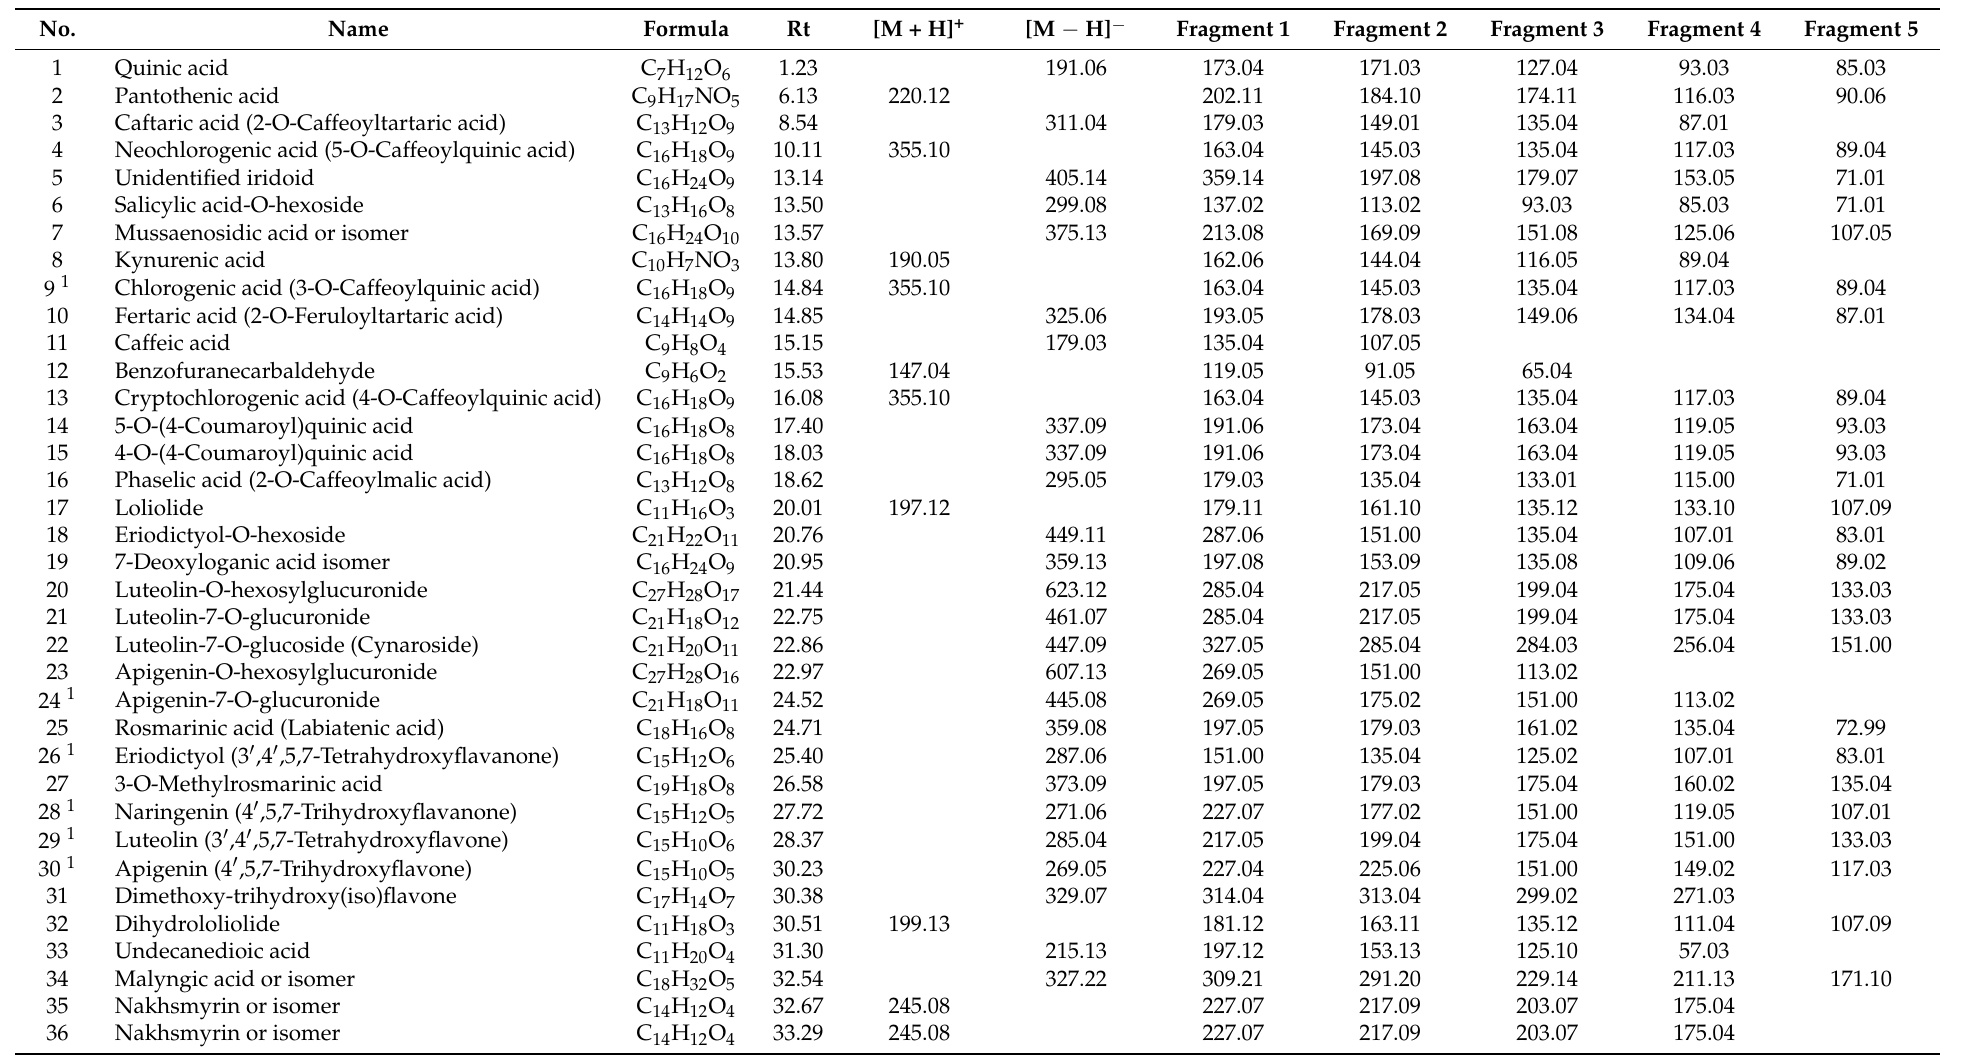
Table 2. Chemical composition of the methanol